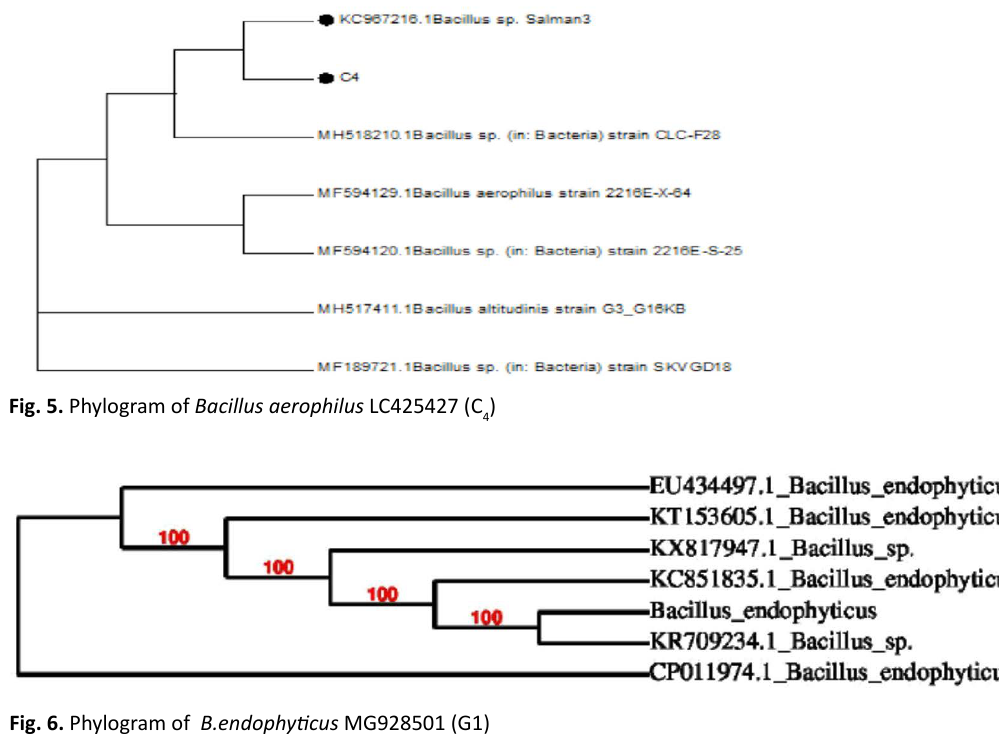
Fig. 6. Phylogram of B.endophyticus MG928501